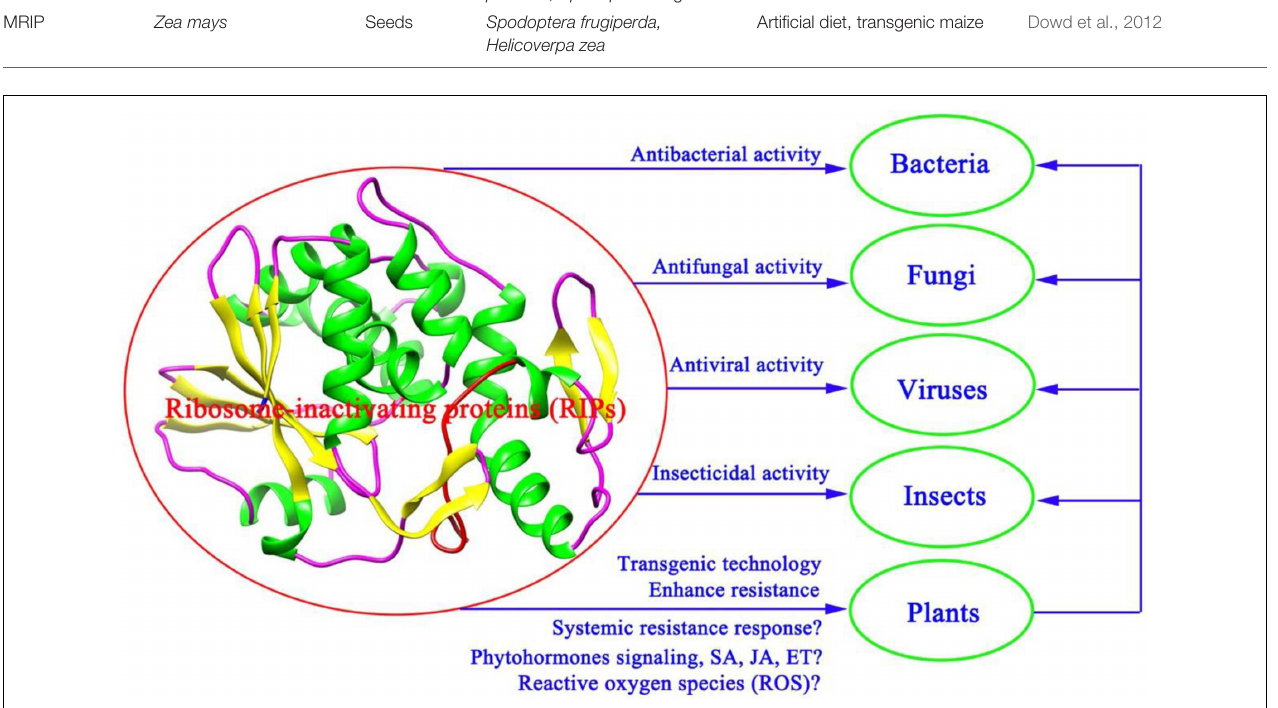
1997; Wang et al., 2016). Expressing α -MMC by transgenic technologies in rice confers enhanced resistance to rice blast fungus (Qian et al., 2014). Future research employing